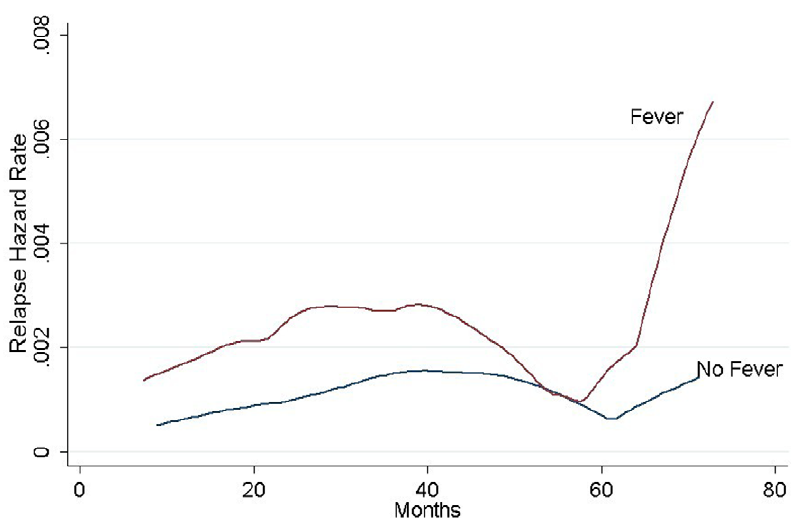
Figure 3. Annual relapse hazard rate for 883 ALN negative breast cancer patients by postoperative fever.